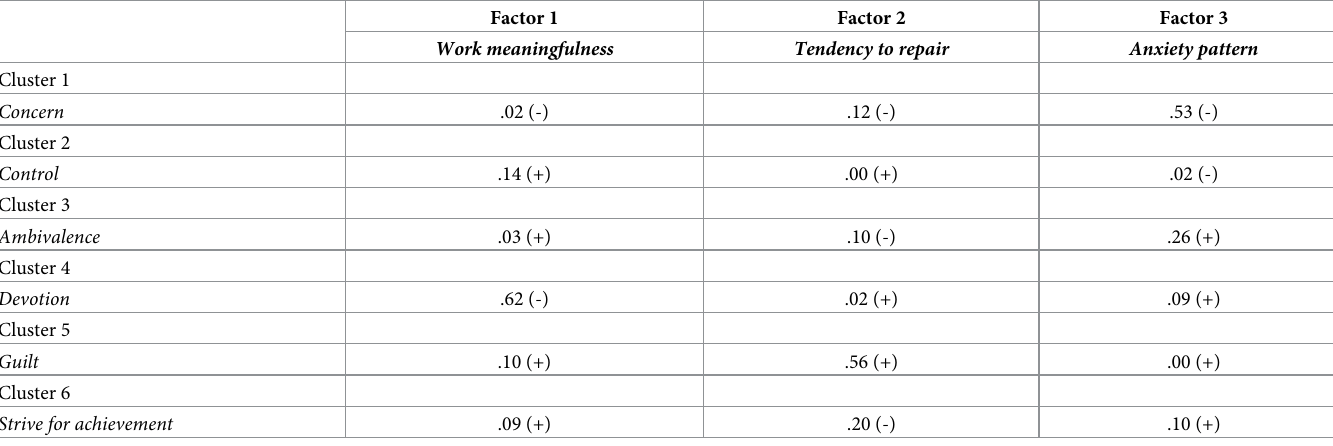
Table 2. Absolute contributions of clusters to each